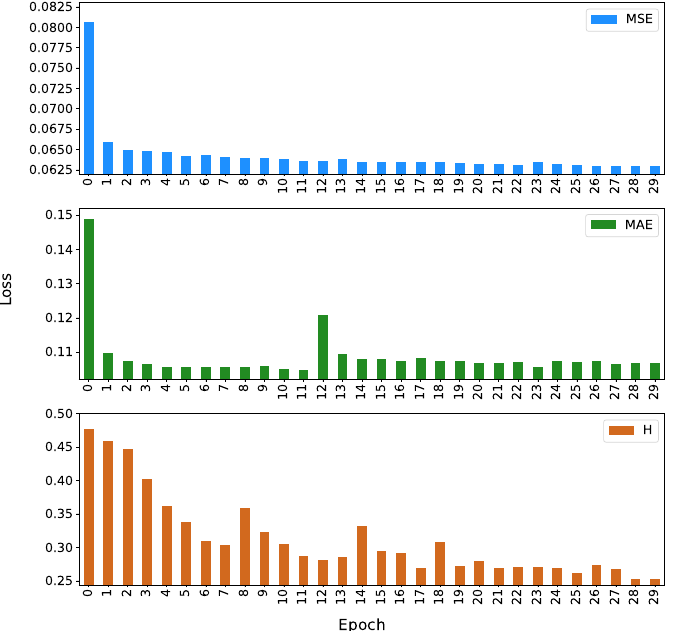
Figure 4. Long Short-Term Memory loss parameter by epochs based on a single day from the CIC-IDS2017